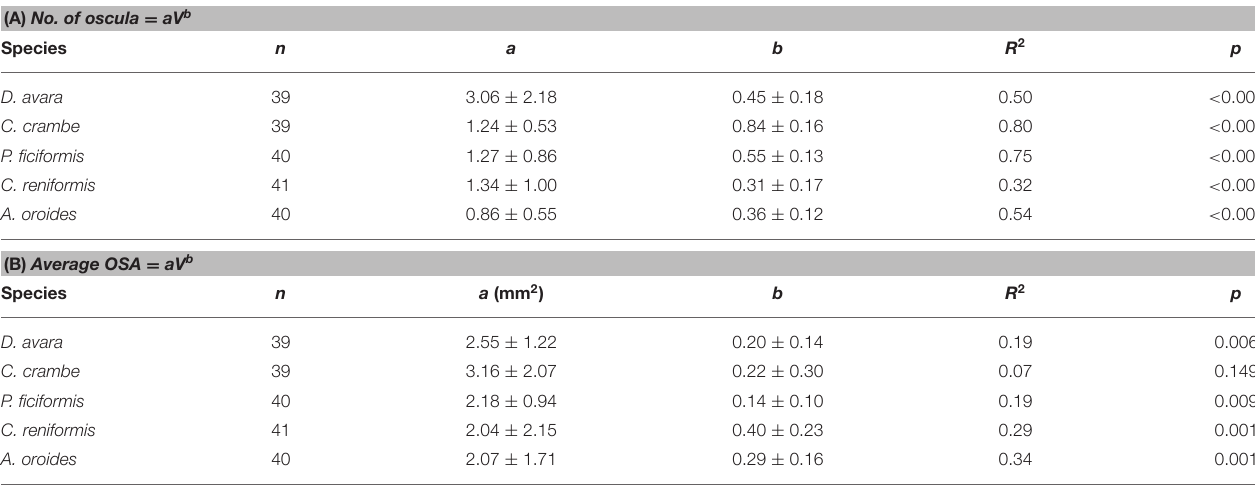
TABLE 3 | The parameters of the allometric function (A) between number of oscula and sponge volume (V, cm 3 ), and (B) between average osculum cross-sectional area (average OSA, mm 2 ) and sponge volume (V, cm 3 ) in the five studied Mediterranean sponge species. (A) No. of oscula = aV